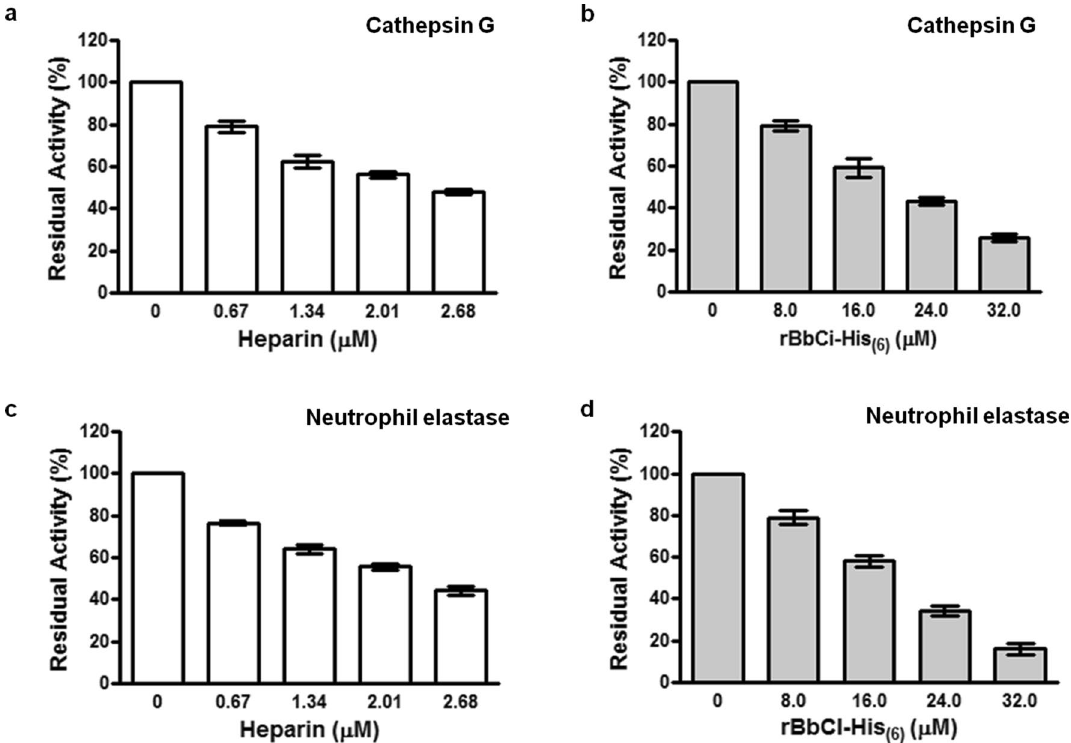
Figure 3. Influence of heparin or rBbCl-His (6) on the enzymatic activity of neutrophil serine proteases. Cathepsin G (0.5 µM) (a , b) or elastase neutrophil (26 nM) (c , d) were pre-incubated (10 min, at 37 °C, 0.1 mM Tris–HCl buffer at pH 7.5 containing 0.5 M NaCl) in the presence of increasing concentrations of heparin (unfractionated heparin) or rBbCI-His (6) , incubated for 30 min at 37 °C. The residual activity of each enzyme was measured using MeO-Suc-Ala-Ala-Pro-Phe-pNan and MeO-Suc-Ala-Ala-Pro-Val-pNan (1 mM) for cathepsin G and elastase, respectively.